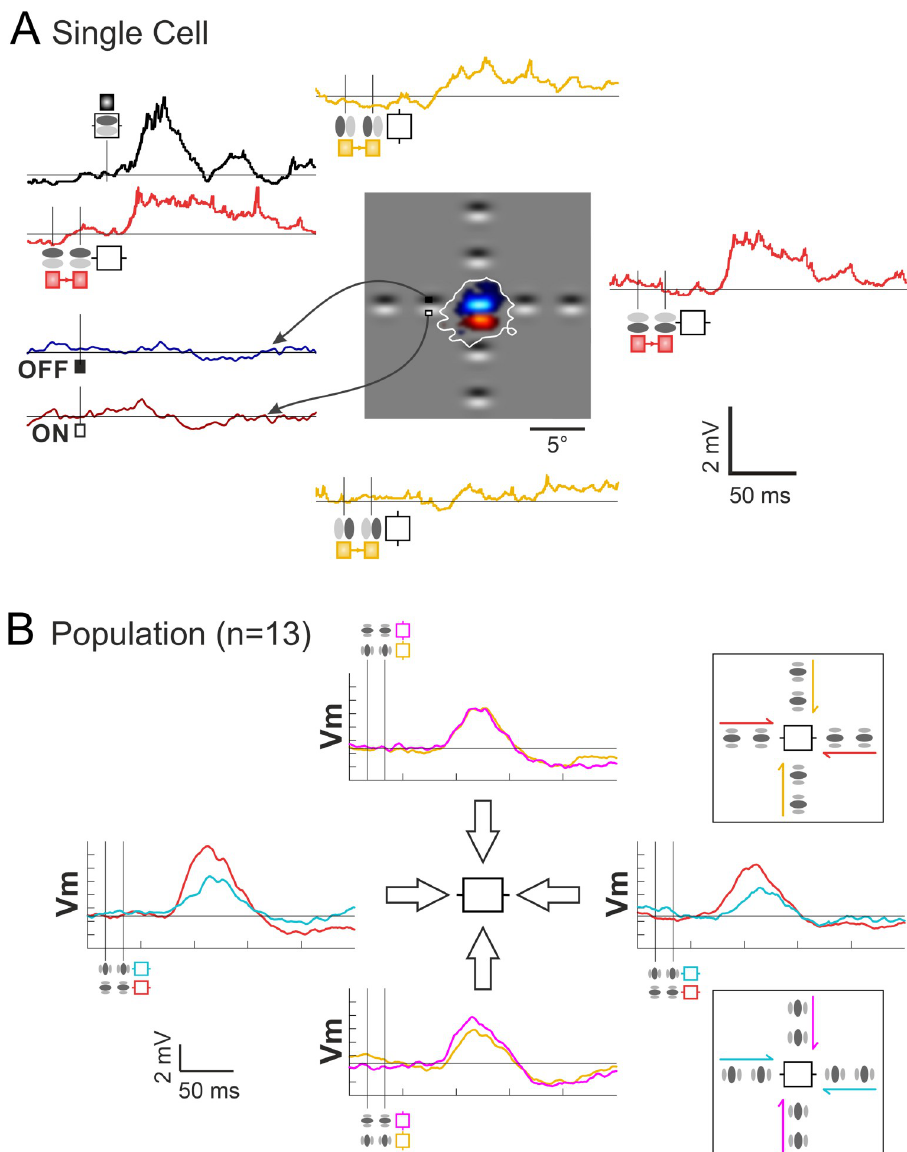
Fig 3. Spatio-temporal and axial selectivity of “Surround-Only” responses to centripetal AM flow. (A) Single Cell example : Central inset cartoon: ON and OFF discharge fields, respectively in red and blue. White contour delineates the subthreshold receptive field (SRF). For comparison, respective positions of the Gabor inducer stimuli flashed in the surround are overlaid on the RF map. Two-stroke “Surround-Only” AM responses: comparison of “collinear” (red) and “parallel” (gold) responses evoked respectively along the orientation preference axis and across the width axis of the RF, with the Center-only response (black waveform). Bottom left corner, Vm subthreshold responses for sparse noise (ON (dark red) and OFF (dark blue) waveforms). (B) Dependency of Surround-Only responses on the orientation of the inducer : Right, top and bottom panels illustrate the Gabor inducer features and the color codes for the motion axis explored respectively in the ISO-and CROSS-configurations. The color code conventions are: ISO-RF: red for “collinear” along the orientation preference axis; gold for “parallel” across the RF width axis; CROSS-RF: cyan for “parallel” across the orientation preference axis; magenta for “collinear” along the RF width axis. See Text for